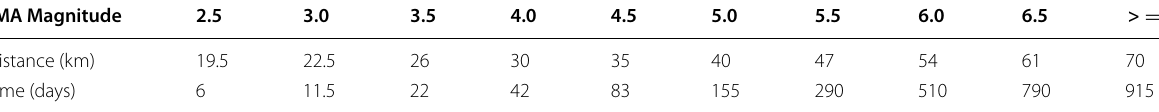
Table 1 Aftershock time–space identification windows (Gardner and Knopoff 1974) JMA